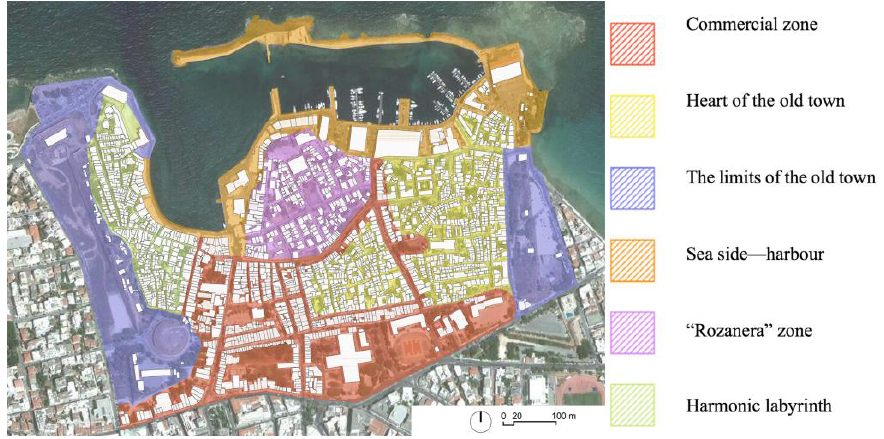
Figure 12. Sound identity map.